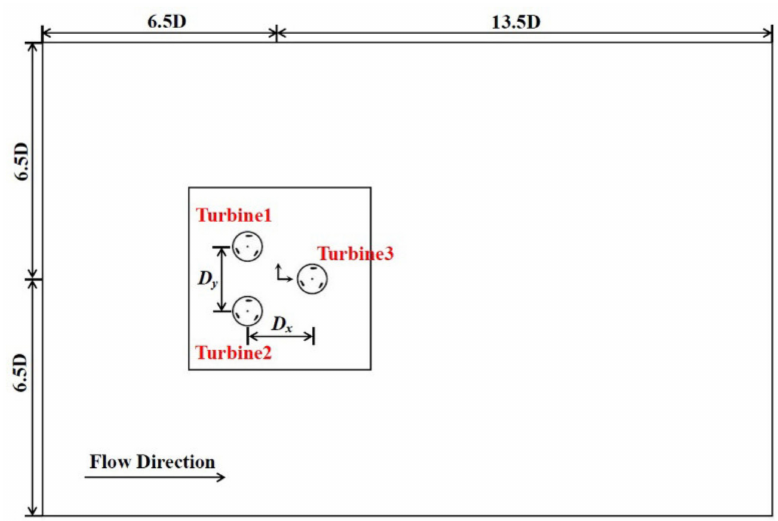
Figure 3. Computational domain of VATT